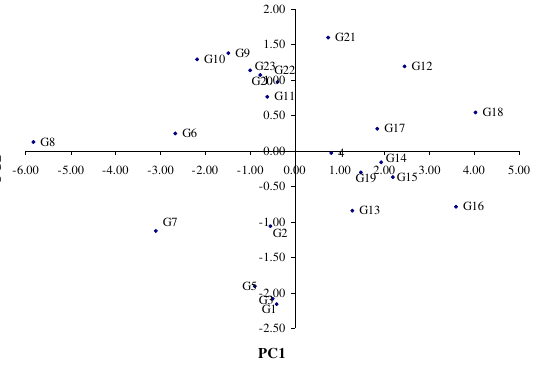
Fig. 2. Influence of PC1 and PC2 in white lupine cultivars. 1- ‘Astra’, 2-‘Nahrquell’, 3-‘Ascar’, 4-‘BGR 6305’, 5-‘Shienfield Gard’, 6-‘WAT’, 7-‘Kijewskij Mutant’, 8-‘Hetman’, 9-‘Start’, 10-‘Amiga’, 11-‘Garant’, 12-‘Tel Keram’, 13-‘Bezimenii 1’, 14- ‘Bezimenii 2’, 15-‘Pflugs Ultra’, 16-‘Termis Mestnii’,